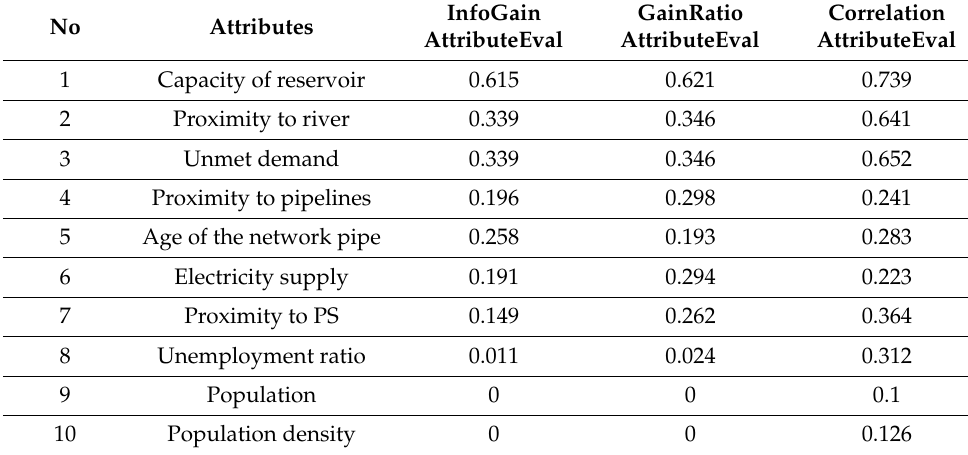
Table 2. Performance of the three ranking algorithms using 10-fold